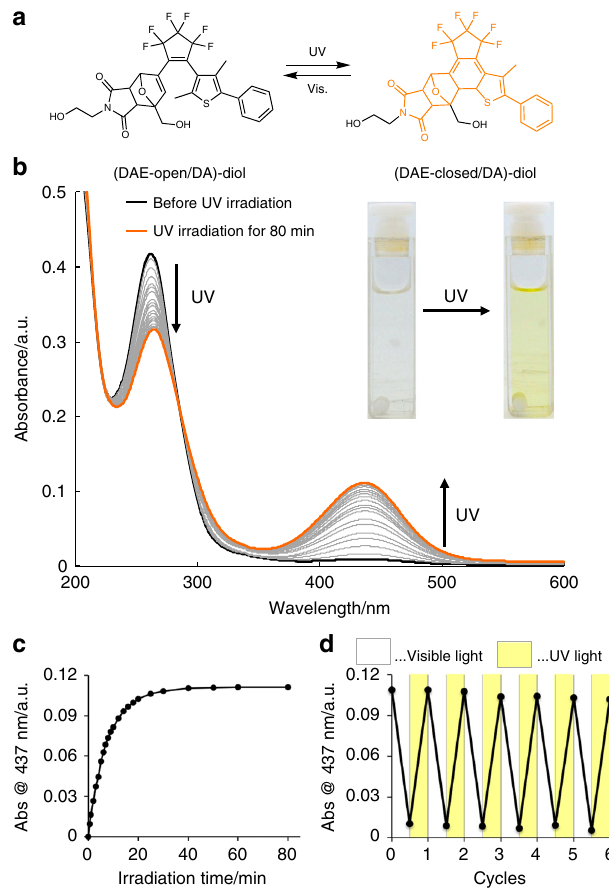
Fig. 2 Model photoregulation reaction of (DAE-open/DA)-diol. a Reversible photoisomerization of DAE/DA-diol. b Time dependence of the UV – vis absorption spectra of an acetonitrile solution of DAE/DA-diol (22.7 µ mol L – 1 ) under irradiation with UV light ( λ = 313 nm). c Time dependence of the absorption at 437 nm under irradiation with UV light ( λ = 313 nm).